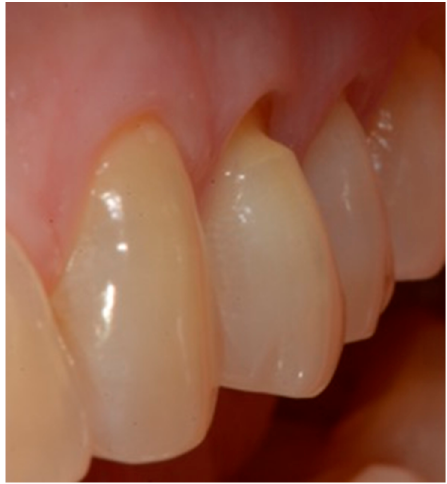
Figure 1. Tooth before restoration.